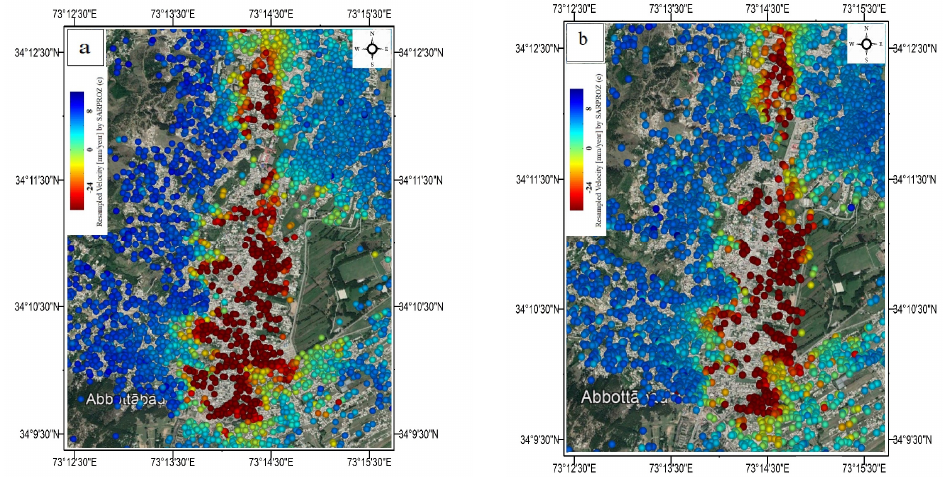
Figure 7. Ground subsidence in the study area from the descending track ( a ) and ascending track ( b ). Figure 7 shows that subsidence in the study area ranges from 0 to approximately − 30 mm, where the red color shows a subsidence of about − 30 mm. Here the (a) represents subsidence in the descending track and (b) represent subsidence in the ascending track.